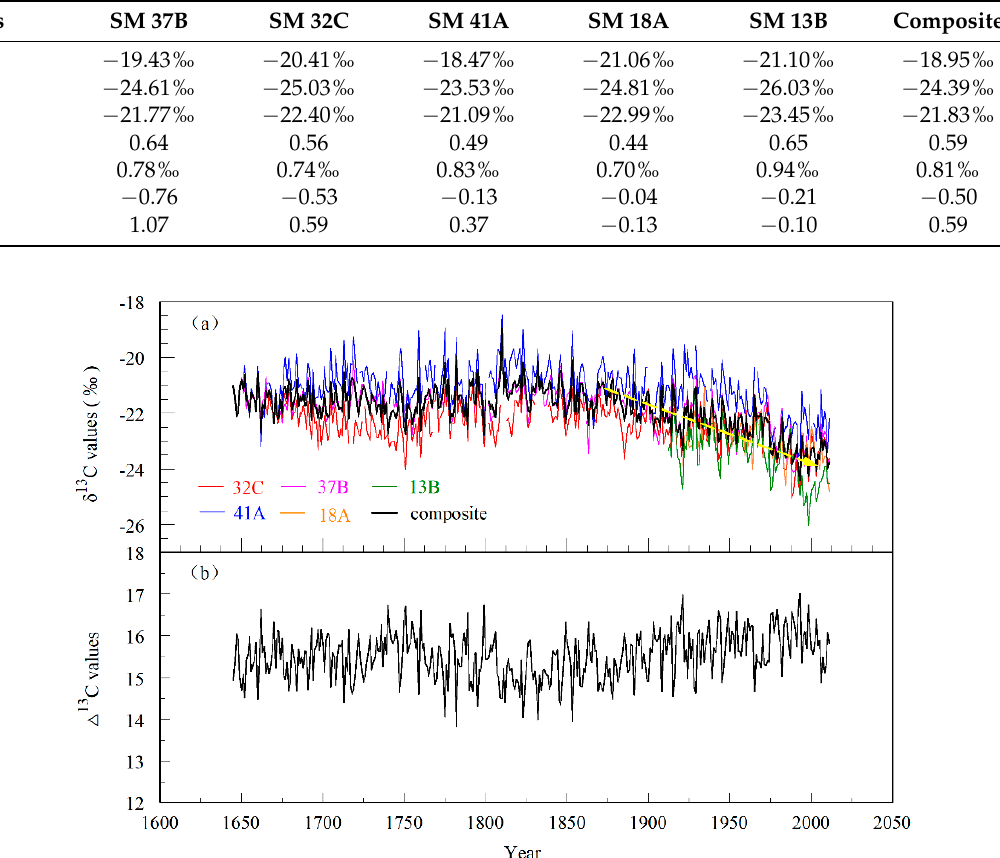
Table 1. Statistical characteristics of individual and composite tree-ring cellulose δ 13 C time series.